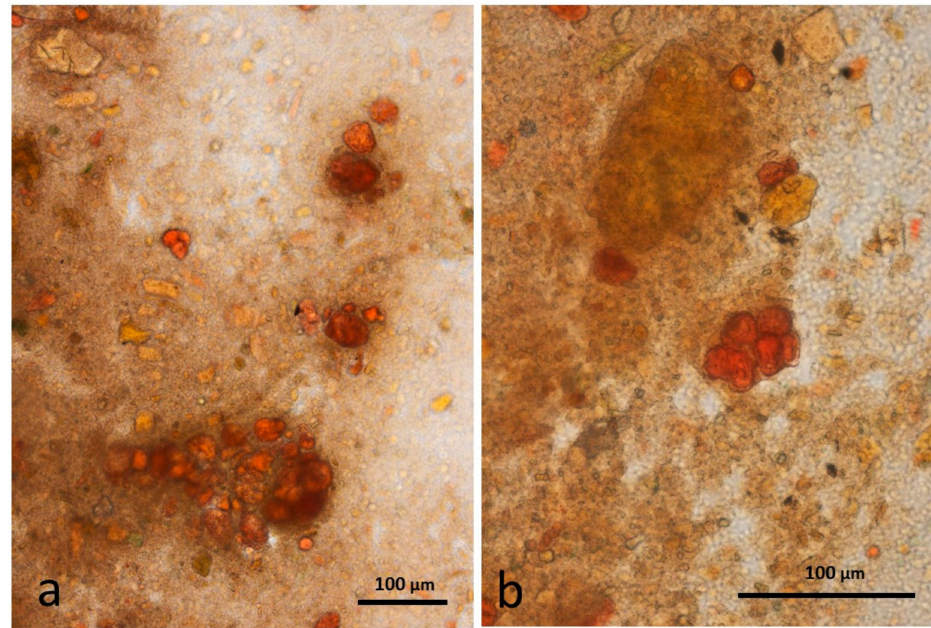
Figure 13. Faecal sample stained with Sudan IV from almond butter diet: ( a , b ) small multicellular particles but very few free lipid